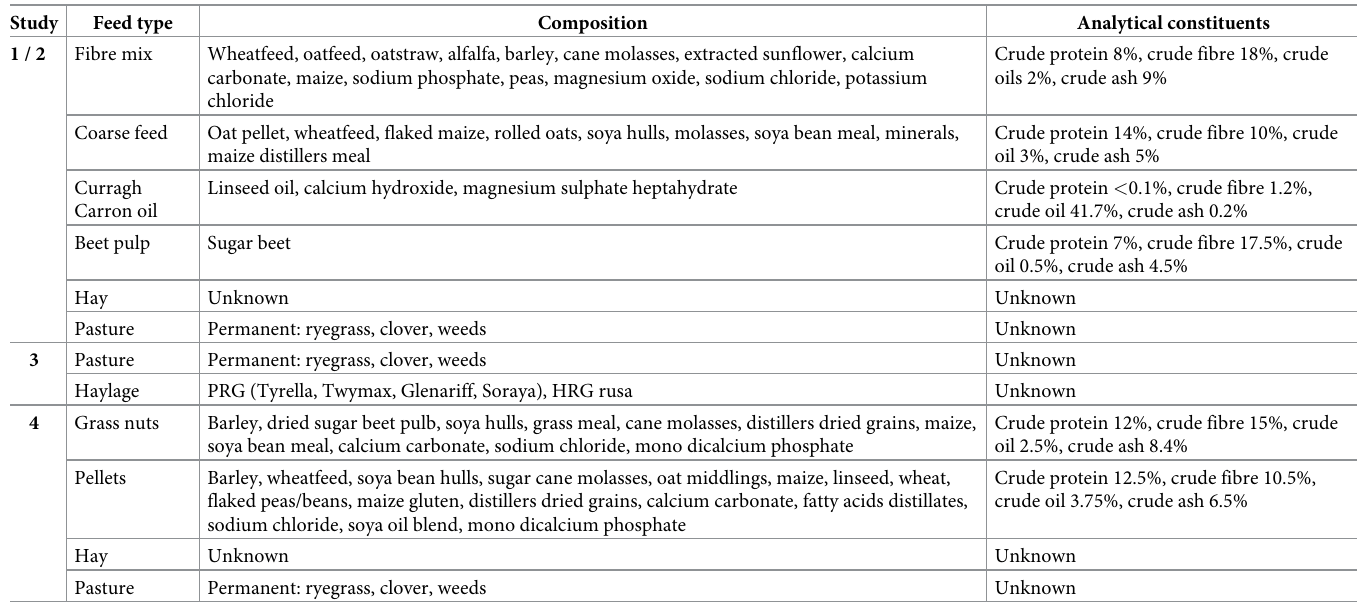
Table 3. Nutritional composition and analytical constituents of feed used in each